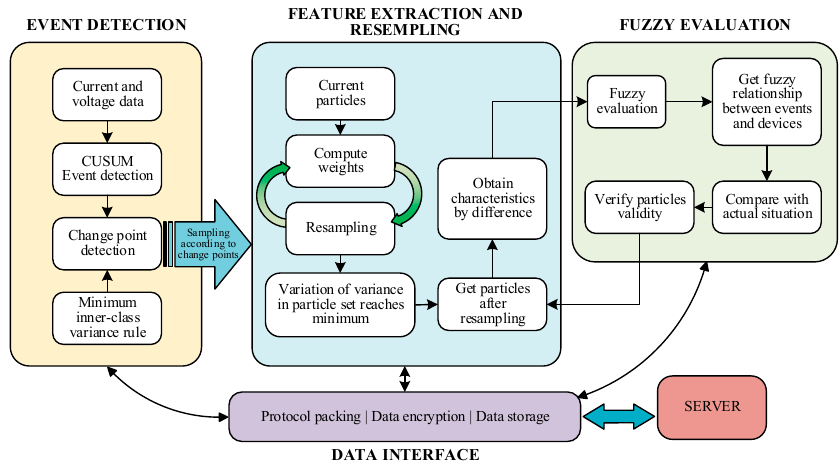
Figure 1. The method